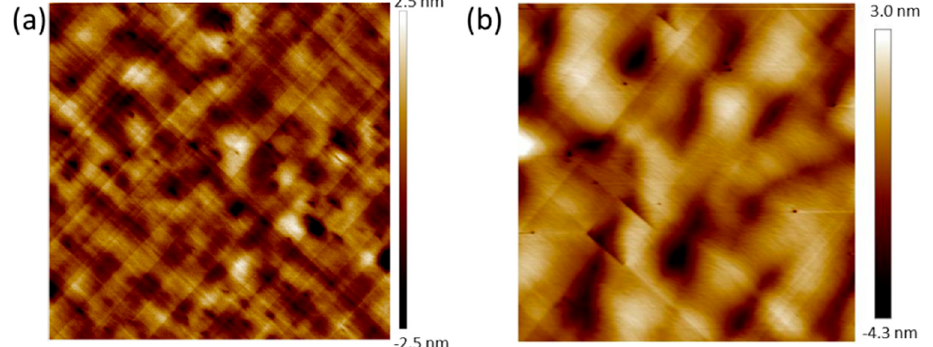
Figure 2. ( a ) A 20 µ m × 20 µ m AFM image of the surface of a 1.5 µ m thick Ge SRB on a Si(001) substrate; and ( b ) a 5 µ m × 5 µ m AFM image of the 350 nm thick GaAs bu ff er on a Ge-bu ff ered silicon (001) substrate.